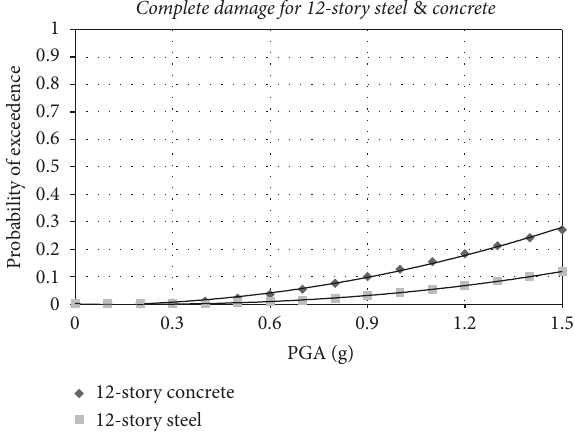
Figure 6: Comparison of the fragility of the 12-story steel and RC frame buildings for the complete damage state.